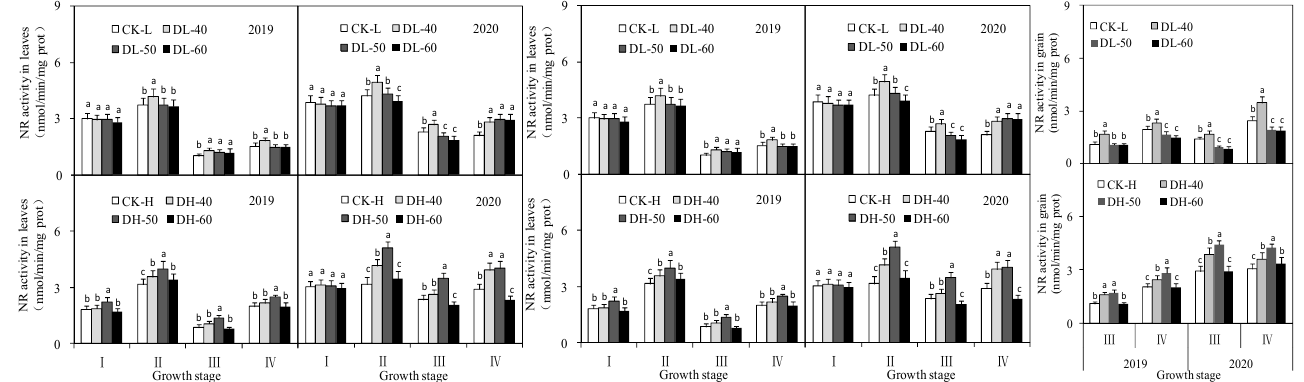
Figure 4. Effects of density and fertilization on NR activity in organs of forage maize. Note: Different letters on bars indicate significant differences among treatments at the 0.05 probability level.